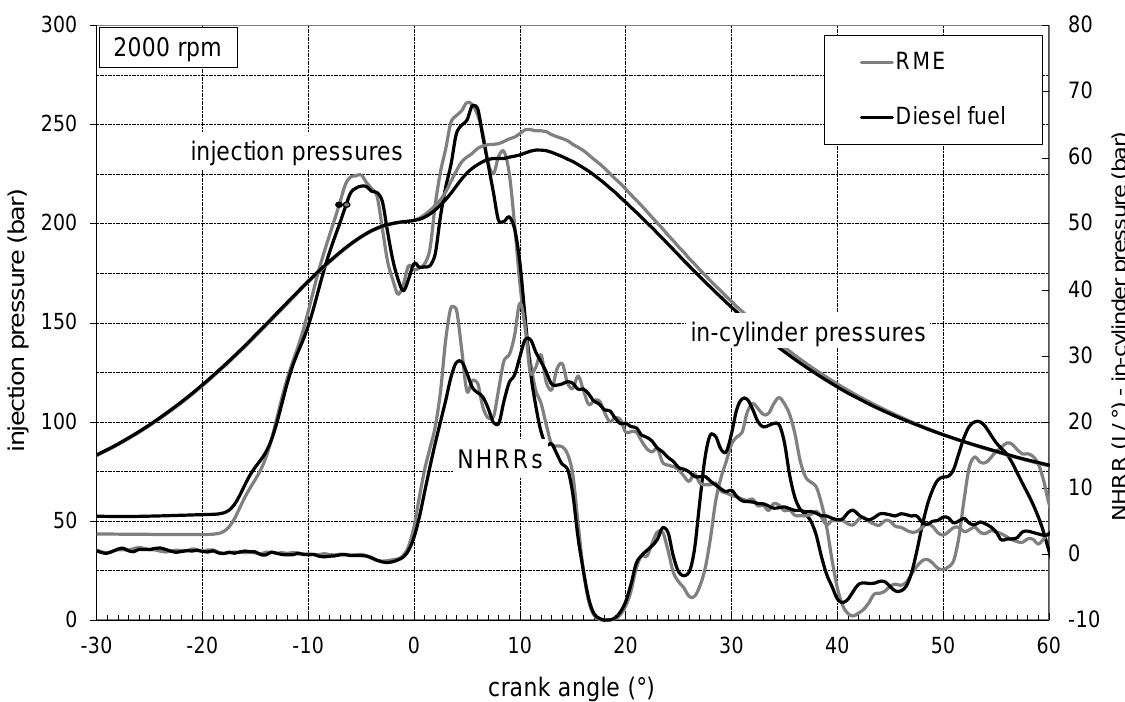
Figure 7. RME and diesel fuel injection pressures, in-cylinder pressures, and NHRR at 2000 rpm and at full load.